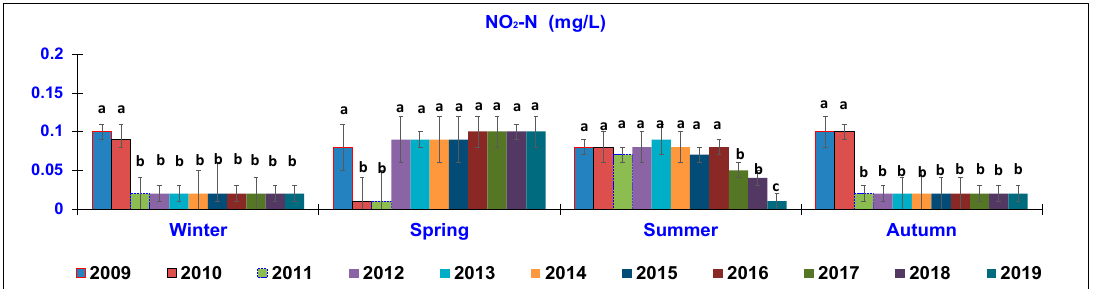
Figure 6. Trend of outlet water Nitrites (NO ₂ -N) (mg/L) (mean ± standard deviation) seasonally determined during the 10 year-study. Different letters (a, b, c) per season show significant differences ( p < 0.05) among the 10 years of sampling.